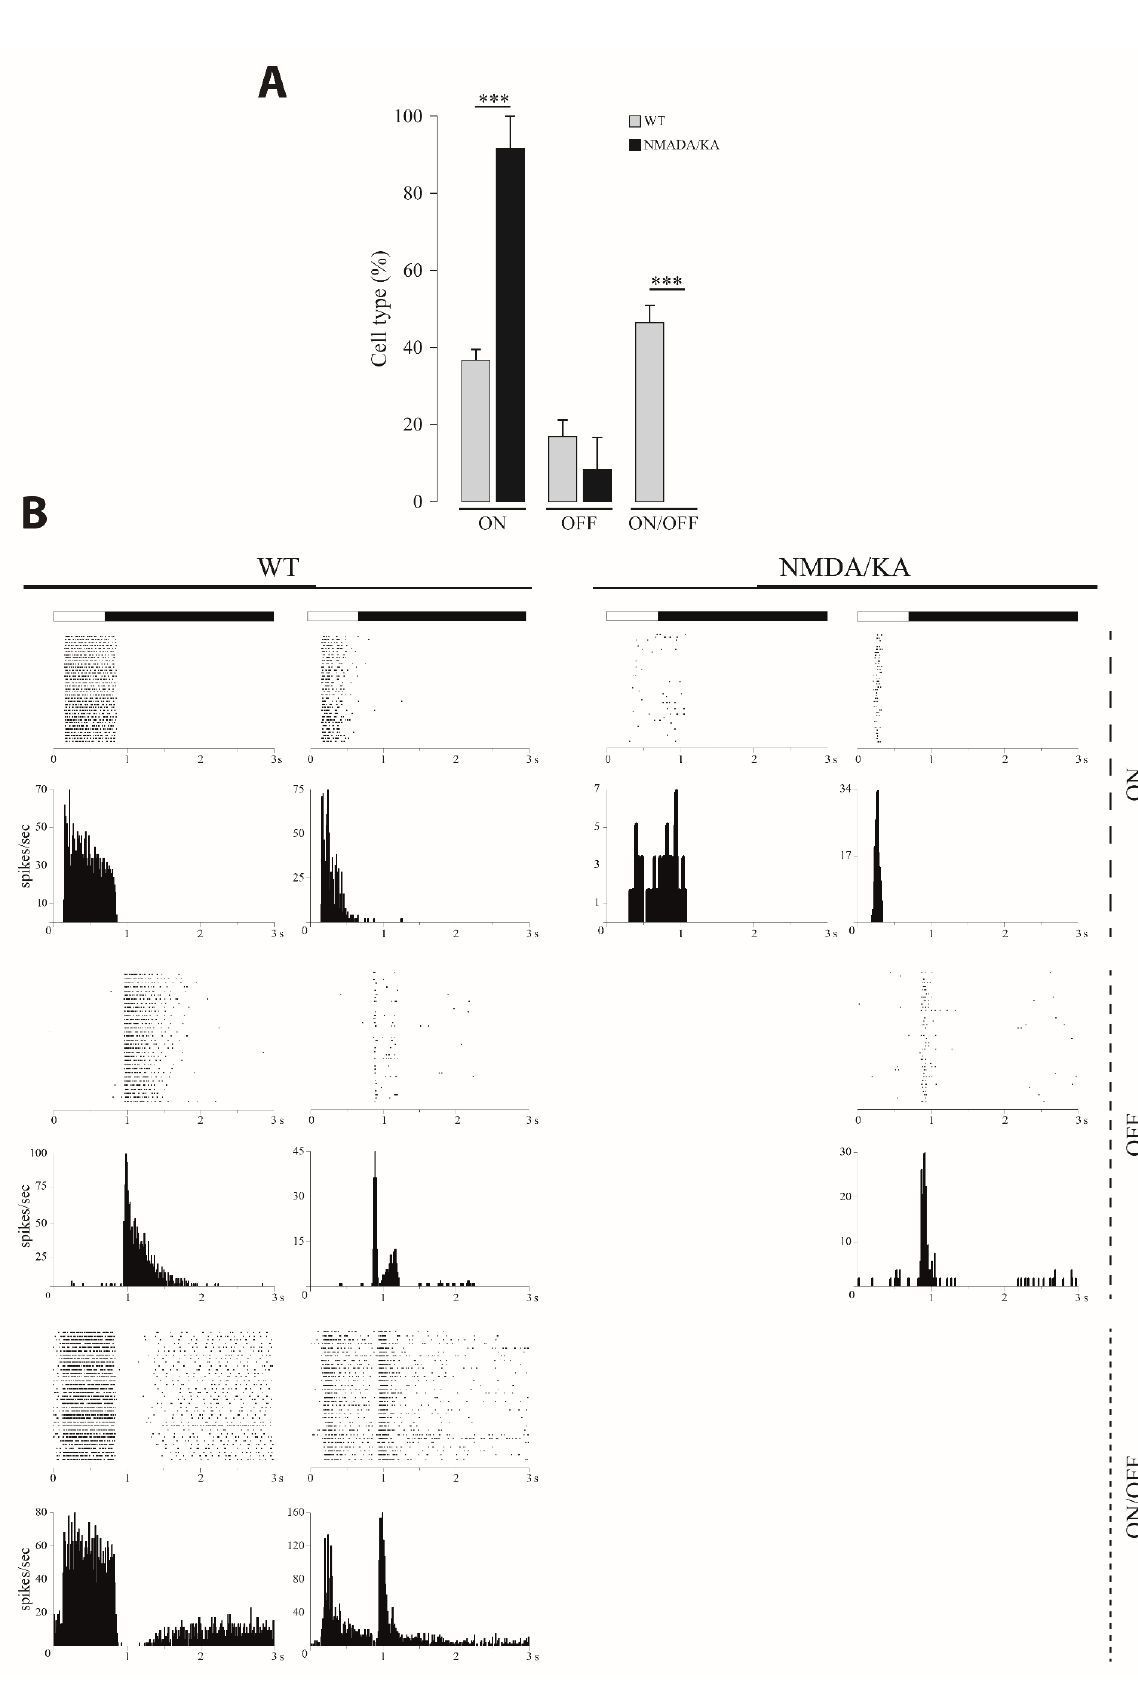
Figure 4. Quantification of the different retinal ganglion cells (RGC) types responses. ( A ). Percentages of the different functional types of RGC (ON, OFF, and ON/OFF) recorded in the control/wild type (WT retinas ( n = 4) and those